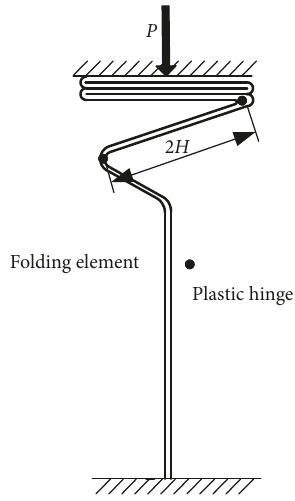
Figure 1: Plastic hinge model of metal